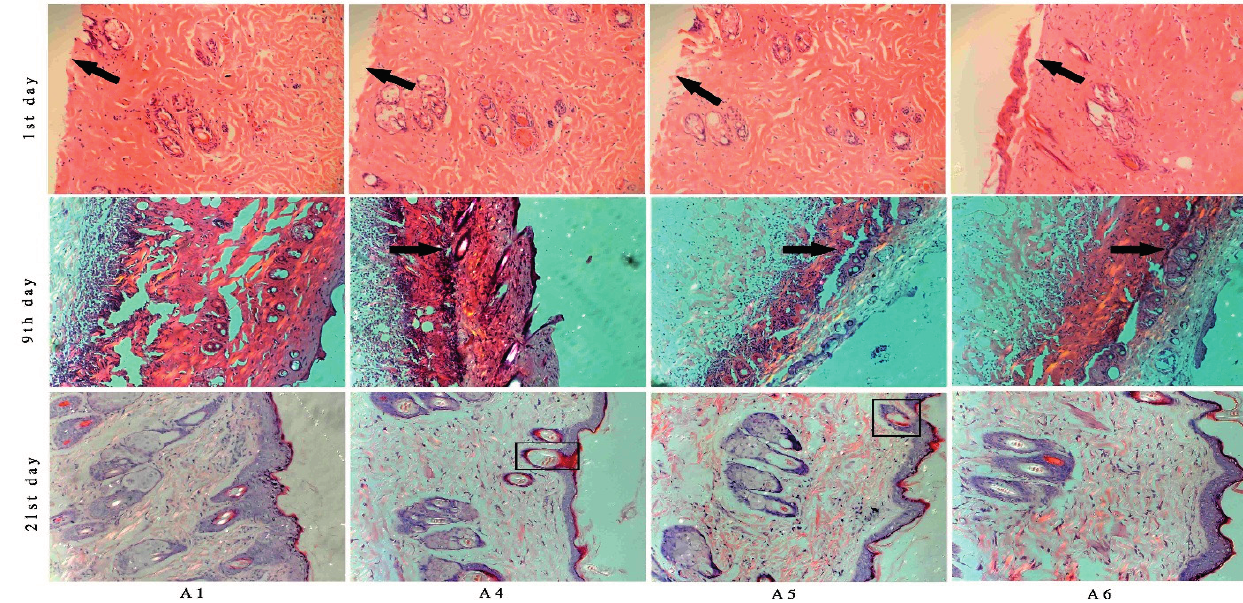
Figure 9. Histopathology of burned tissues samples after treatment with different concentration of BBO at Days 1, 9 and 21 (stained with Hematoxylin-Eosin). On the first day after